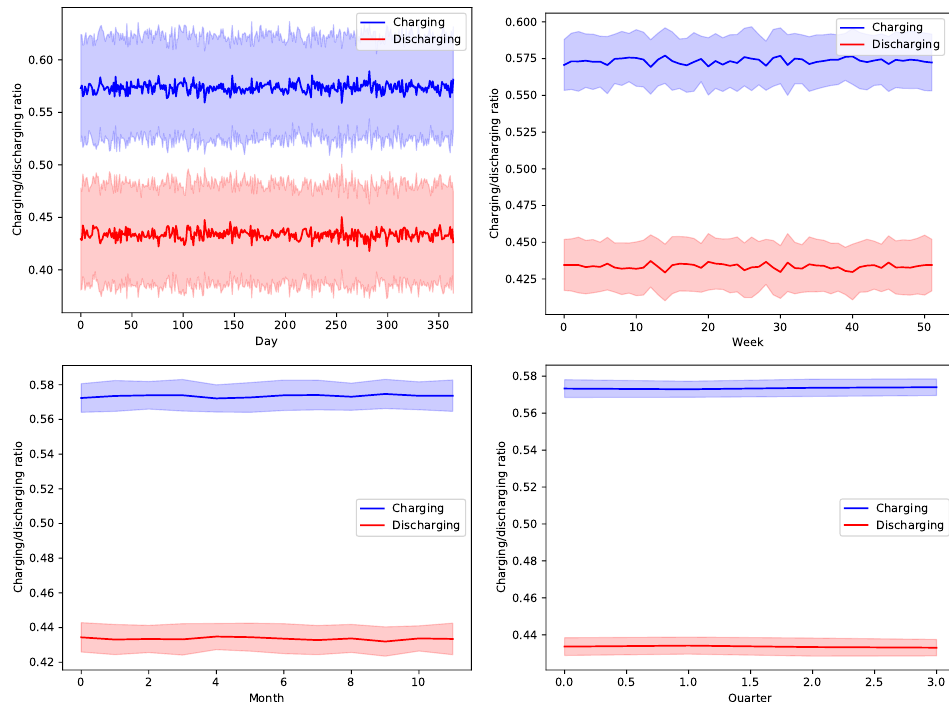
Figure 14. The average temporal charging and discharging ratios of EVs according to the greedy policy with a global certainty level U 25